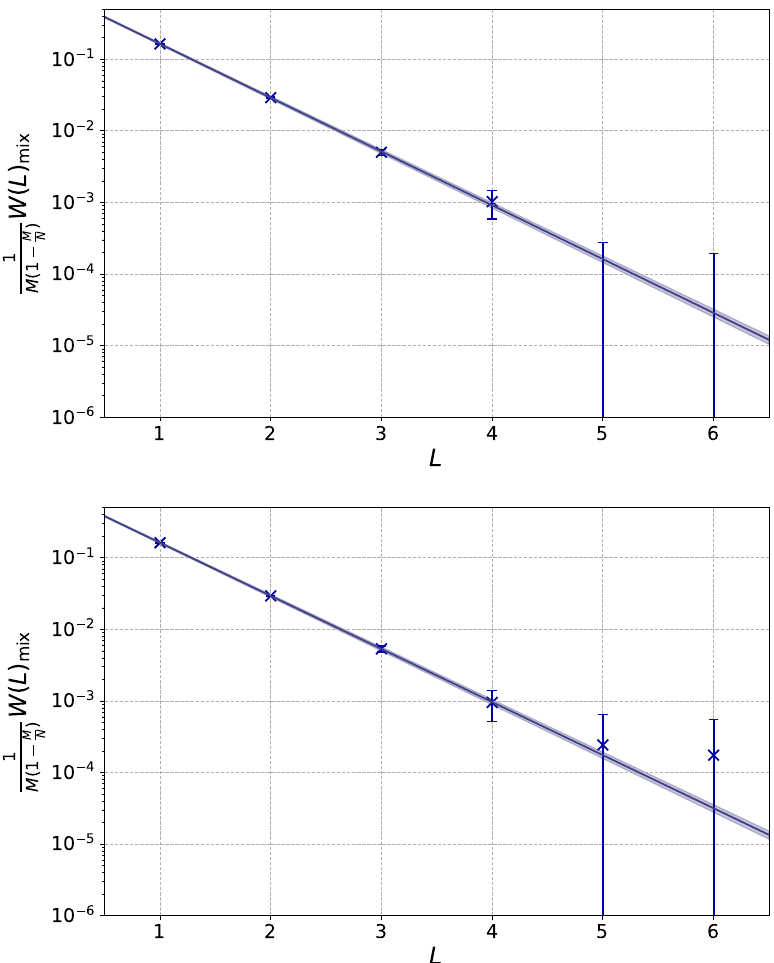
Figure 9. Mixed subsector Wilson loop, W mix , at T = 0 . 29 , for P = 0 . 2 and P = 0 . 25 , respectively. We have extrapolated to the large N limit using N = 24 , 32 , 64 , and to the continuum limit using n t = 16 , 24 , 32 for each N , using the 2D interpolation 1 We fitted the interpolated values γ ( L ) for 1 ≤ L ≤ 4 to the ansatz γ ( L ) = exp( − cL + d ) . We find c mix = 1 . 731(21) and c mix = 1 . 708(20) for P = 0 . 2 and P = 0 . 25 , respectively. The fit is shown along with error bounds by the blue